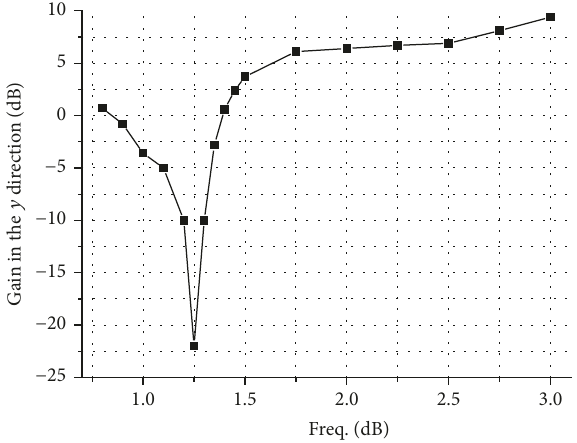
Figure 12: Gain in the 𝑦 direction versus frequency in 2D.